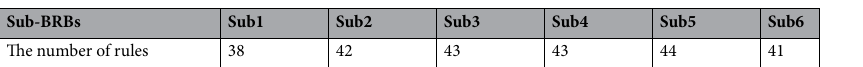
Table 8. The number of rules involved in optimization in each sub-BRB.